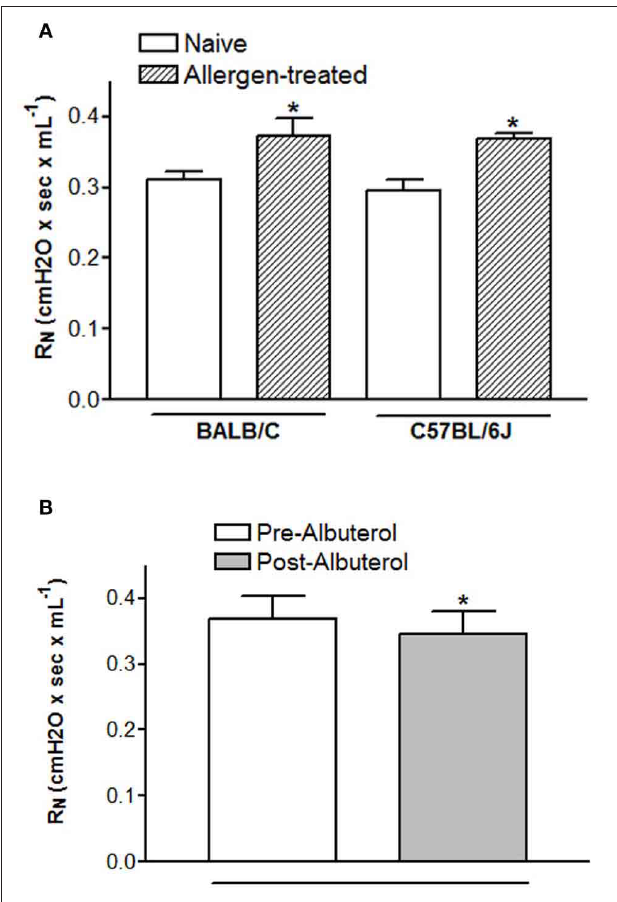
FIGURE 3 | Changes in baseline resistance are measureable in mice. Baseline resistance was measured using the forced oscillation technique in anesthetized, paralyzed, tracheotomized mice 24h after the last OVA challenge (Lin et al., 2012). Duplicate measures of baseline resistance were made in all mice. Animal experiments used to acquire these data were approved by the Duke IACUC. (A) and (B) BALB/C mice were sensitized by i.p. injection with 10 ug OVA adsorbed to 2.5mg alum on days 0 and 14 and challenged by aerosol exposure with 1% OVA for 1h on days 21, 22, and 23 (Walker et al., 2003). The effect of 60ug/kg i.v. albuterol on baseline resistance was assessed 1min after it was administered. (B) C57BL/6J mice were sensitized by i.p. injection with 10ug OVA adsorbed to 2mg alum on days 1 and 6 and challenged by intranasal insufflation 25 μ L OVA (0.2% w/v in saline) containing 2.5nM of short scrambled peptide. ∗ p < 0 . 05 from naïve (A) or pre-albuterol (B) as assessed by student’s t